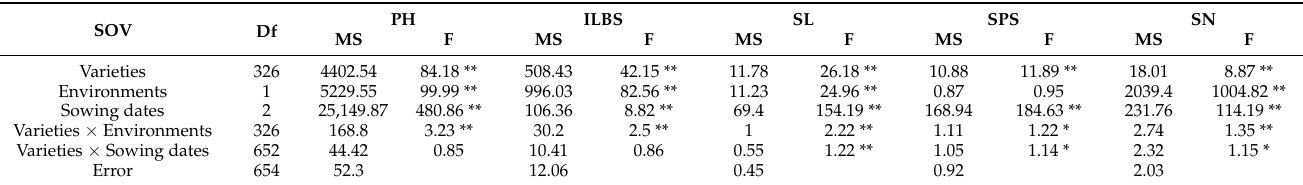
Table 2. Variance analysis of wheat plant height traits and spike-related traits.